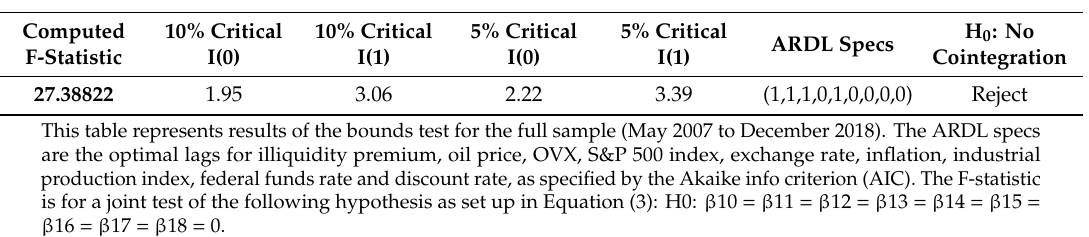
Table 14. The results of the bounds test for cointegration (full